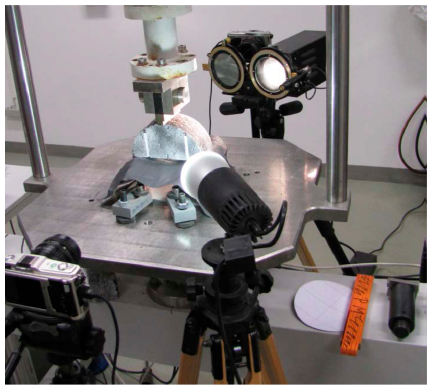
Figure 3. Experimental setup of the dynamic 3PSCBT.